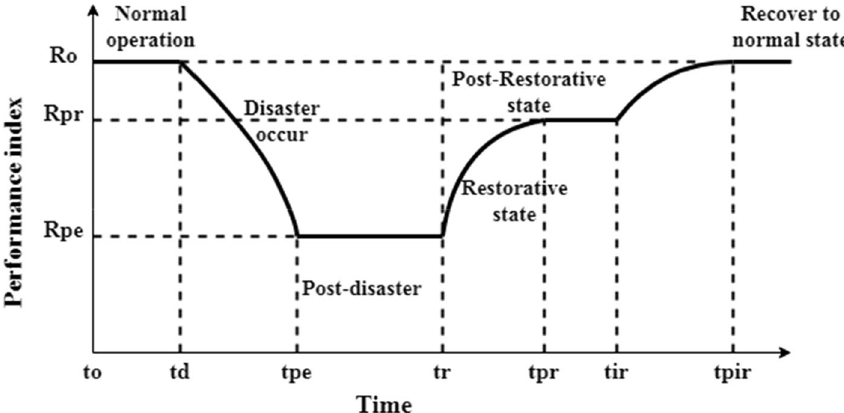
Figure 1. Conceptual resilience curve with a physical natural